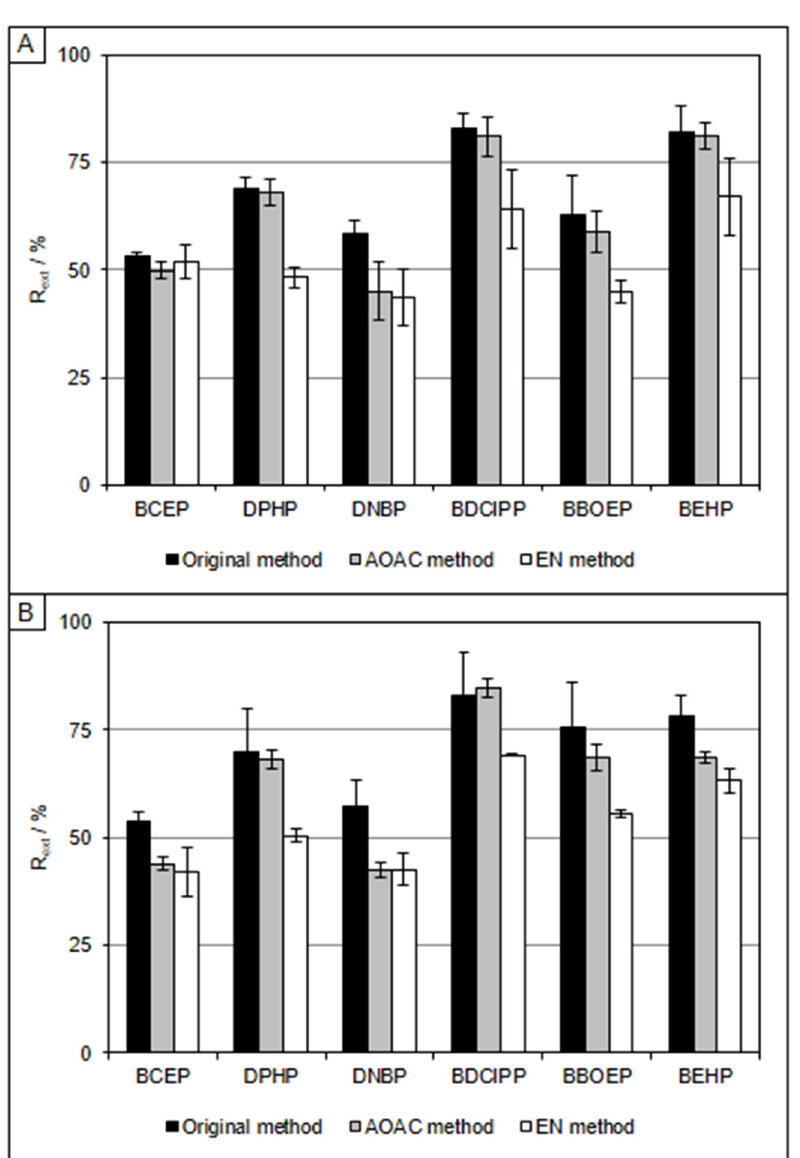
Figure 2. Extraction recoveries obtained for hake ( A ) and mackerel ( B ) samples using different extraction methods with acetone.